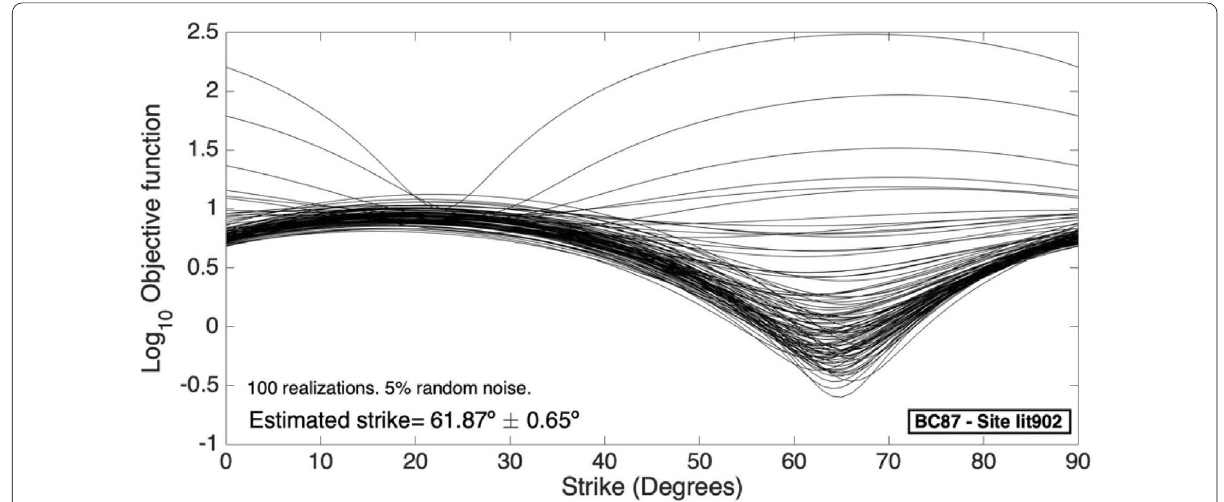
Fig. 12 Estimation of strike using Eq. (7) for all available